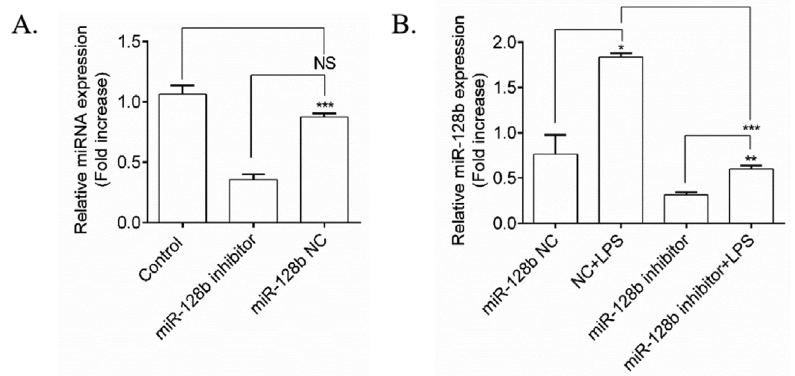
Figure 2. (A, B) miRNA expression using real-time quantita- tive Polymerase Chain Reaction (qRT-PCR). Human Pulmonary Microvascular Endothelial Cells (HPMECs) were evaluated after 24 h of transfection with an miR-128b inhibitor (50 nM) or NC (10 nM) treated with Lipopolysaccharide (LPS) (1 μ g/ mL). The gene and protein expression levels were normalized to those of the control group or NC ( n = 4). Data are repre- sented as mean ± SEM. * p < 0.05, ** p < 0.01, *** p < 0.001.